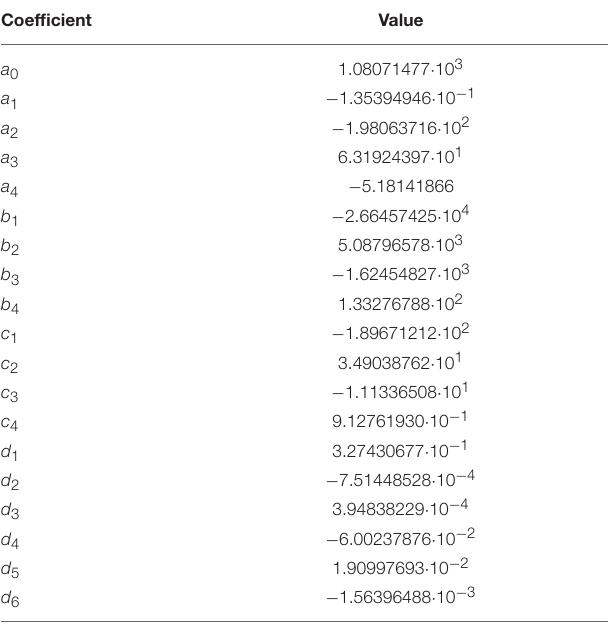
TABLE 1 | Coefficients of equation 9 fitted to the combined data set displayed in Figure 2A .